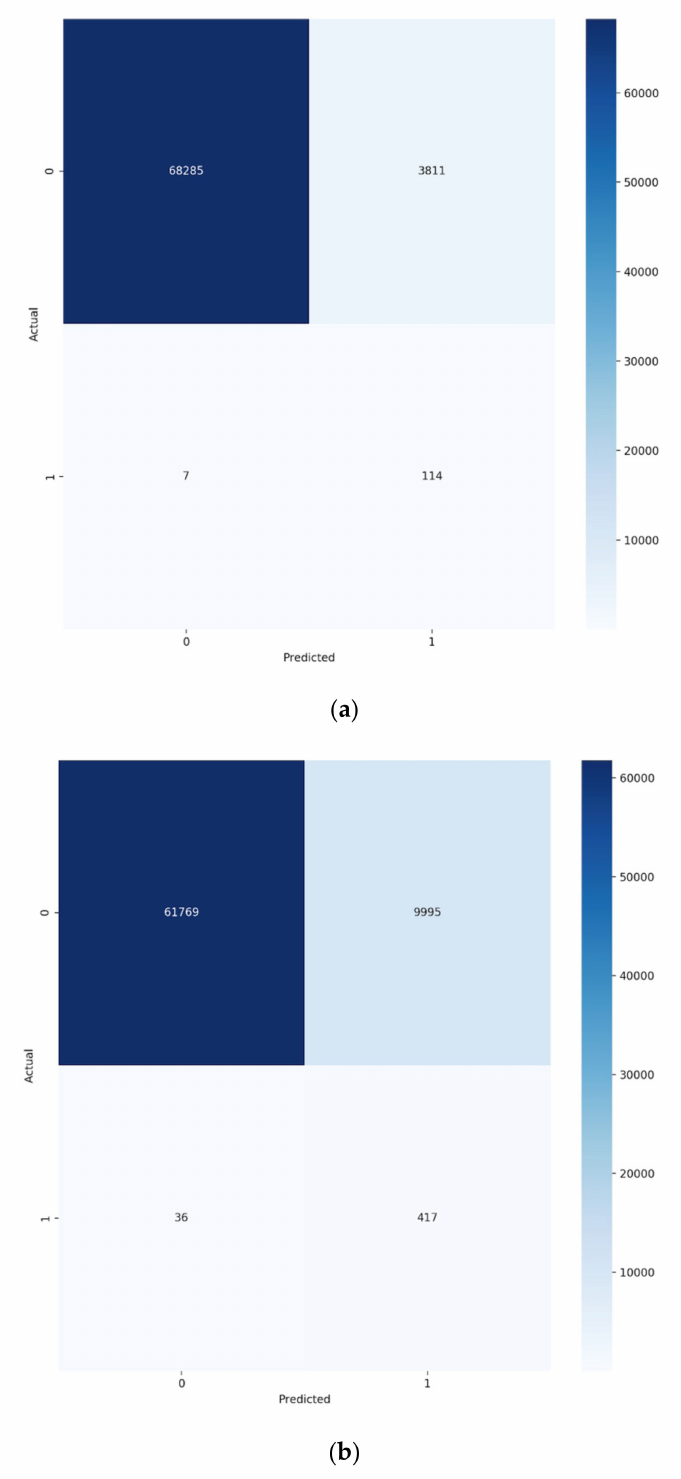
Figure 7. ( a ) Confusion matrix of the ensemble model 48-h in-hospital mortality predictions using Youden’s index cut-off ( b ) Confusion matrix of the ensemble model predictions for overall in-hospital mortality using Youden’s index